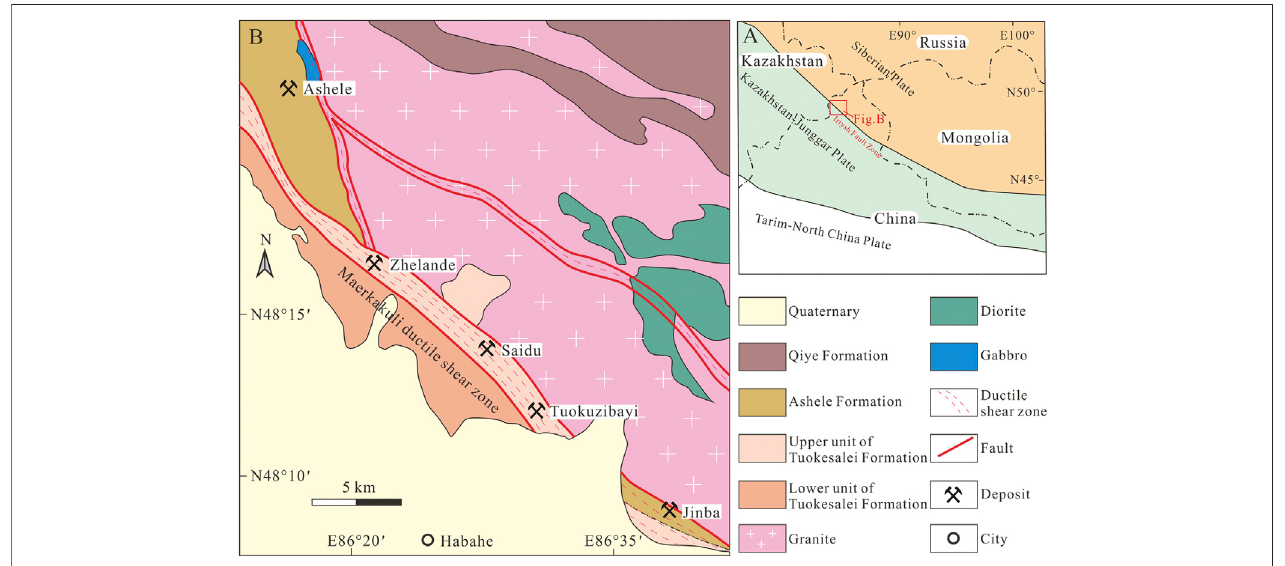
FIGURE 1 | (A) Tectonic map of western China. (B) Regional geological map of the southwestern Chinese AOB (modi fi ed after Zhou et al.,